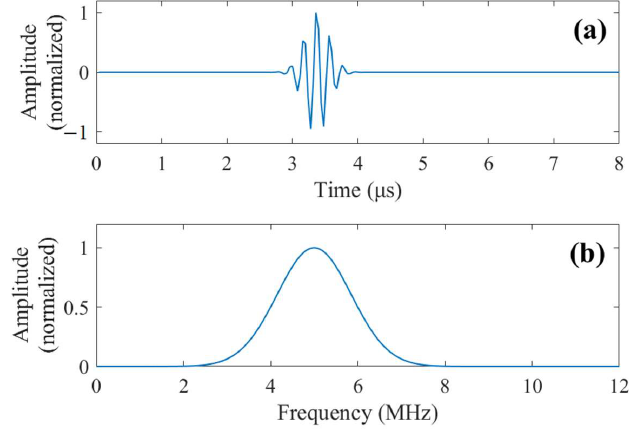
Figure 4. ( a ) Waveform of the transmitted pulse from the transducer. ( b ) Frequency spectrum of the transmitted pulse.